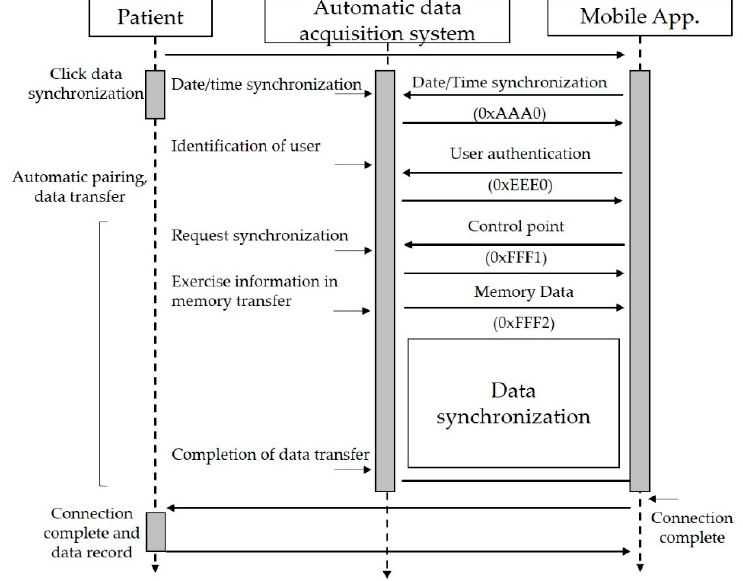
Figure 6. The data synchronization process between aerobic equipment and smartphone application in the proposed therapeutic exercise platform.